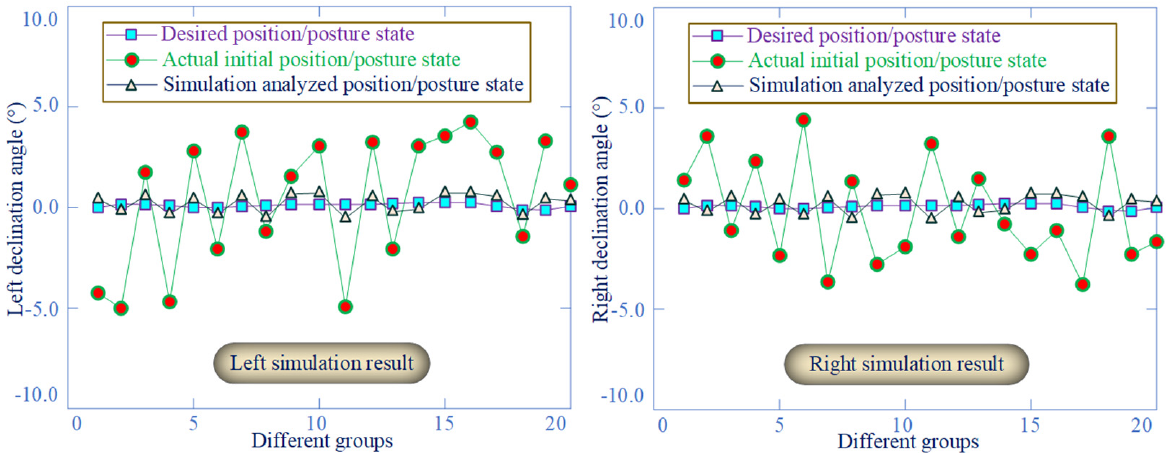
Figure 12. Simulation results of declination angles.